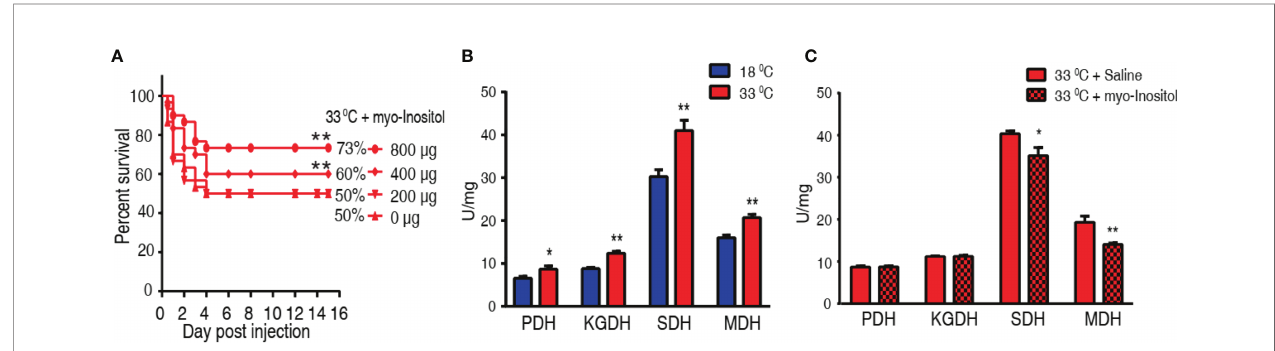
FIGURE 7 | Myo -inositol impacts the TCA cycle and promote tilapia ’ s ability against bacterial infection. (A) Survival of tilapias post A sobria infection in the presence of myo -inositol. Tilapias were treated with saline control (0 µg per fi sh) or different doses of myo -inositol (200, 400, and 800 µg per fi sh) at 33°C for 3 days, followed by bacterial challenge through intraperitoneal injection (1 × 10 5 CFU A. sobria ). The accumulative fi sh death was monitored for a total of 15 days postinfection (n =30 per group). (B) Activity of PDH, KGDH, SDH, and MDH of spleens at 18°C and 33°C. (C) Activity of PDH, KGDH, SDH, and MDH of spleens in the presence or absence of 800 µg myo -inositol per fi sh. Values are means ± SEM (n = 6 per group), and statistic difference is analyzed with non-parametric Kruskal – Wallis one- way analysis with Dunn ’ s multiple-comparison post hoc test. *p < 0.05; **p < 0.01 (B, C)